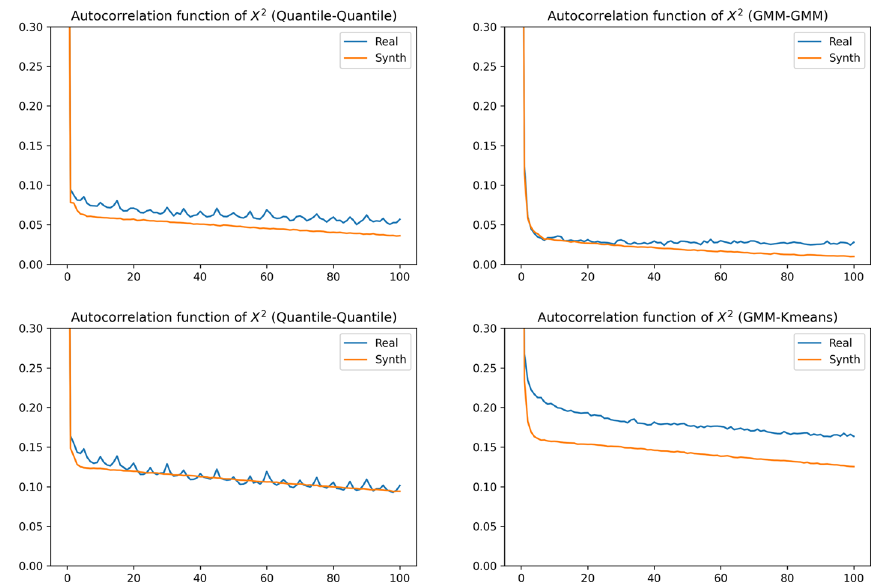
Fig. 3 Autocorrelation function of the simulated WISMC process against the real process. The discretization combinations are: quantile 3-state returns, quantile 3-state index 1-min interval (top-left); GMM 3-state returns, GMM 3-state index 1-sec interval (top-right); quantile 5-state returns, quantile 5-state index 1-min interval (bottom-left); GMM 5-state returns, k-means 5-state index 1-sec interval (bottom-right)